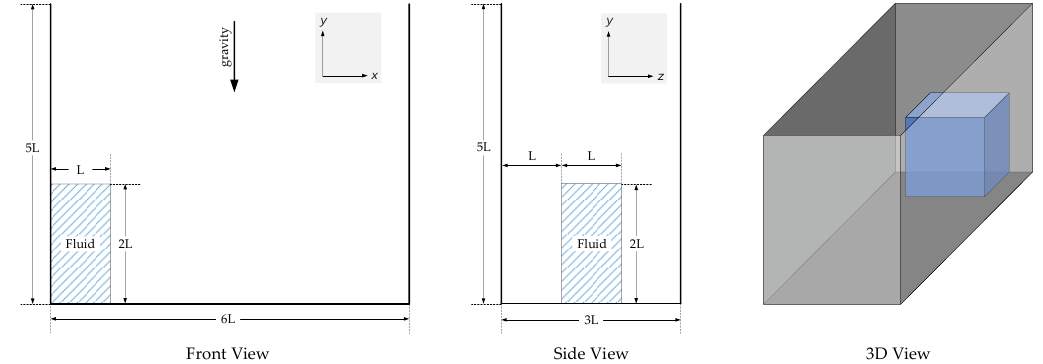
Figure 1. Design drawing of dam break scene. The unit of length used in dam break scene is dimensionless, and its specific length can be set by L. The figure shows a three-dimensional schematic diagram of the scene, as well as side and front